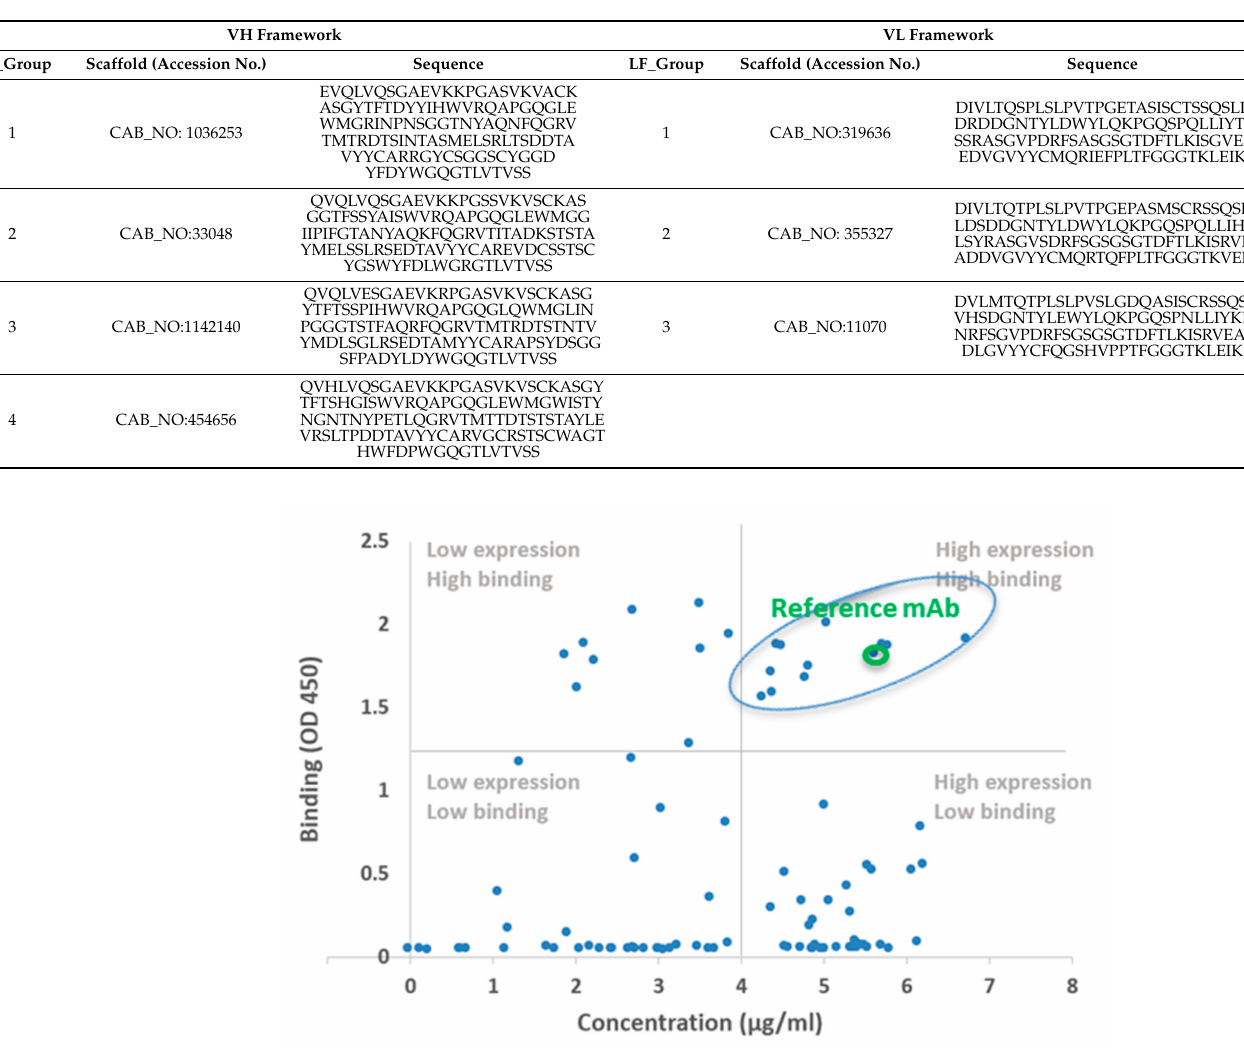
Figure 3. The genesis of CB79 using a CDR–FWR shuffling approach. The X-axis shows the protein expression level as protein concentration obtained from 1 mL and the Y-axis shows the OD value from the ELISA-based screening of antigen binding (see Methods) in the designed antibodies. CB79 was selected from candidates in the quadrant of high expression and high binding based on its improved properties, including its in silico developability and binding compared to H4. The nomenclature of the designed constructs and their heavy- and light-chain groups (from Tables 1 and 2) and their expression and antigen-binding properties relative to the template H4 antibody are shown in Supplementary Figure S2. Antibodies that expressed and showed RBD binding comparable to (or greater than) H4 (highlighted by the green circle) and satisfied the immunogenicity and developability criteria were identified and taken forward for additional screening for ACE2 inhibition and in vitro